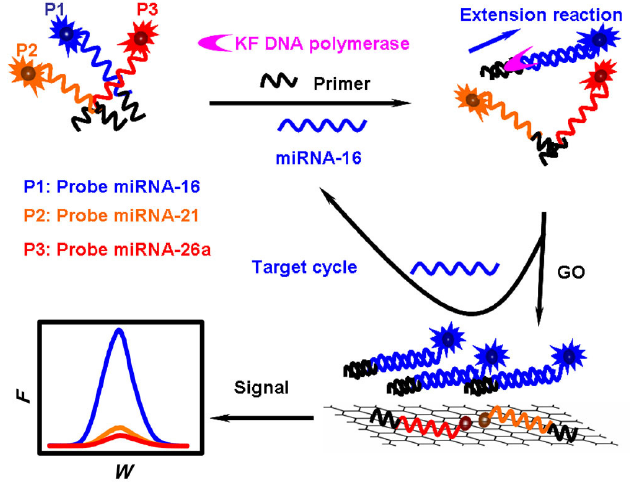
Figure 8. Illustration of the GO fluorescence quenching and ISDPR-based multiple miRNA analysis. Reprinted with permission from [58]. Copyright 2012 American Chemical